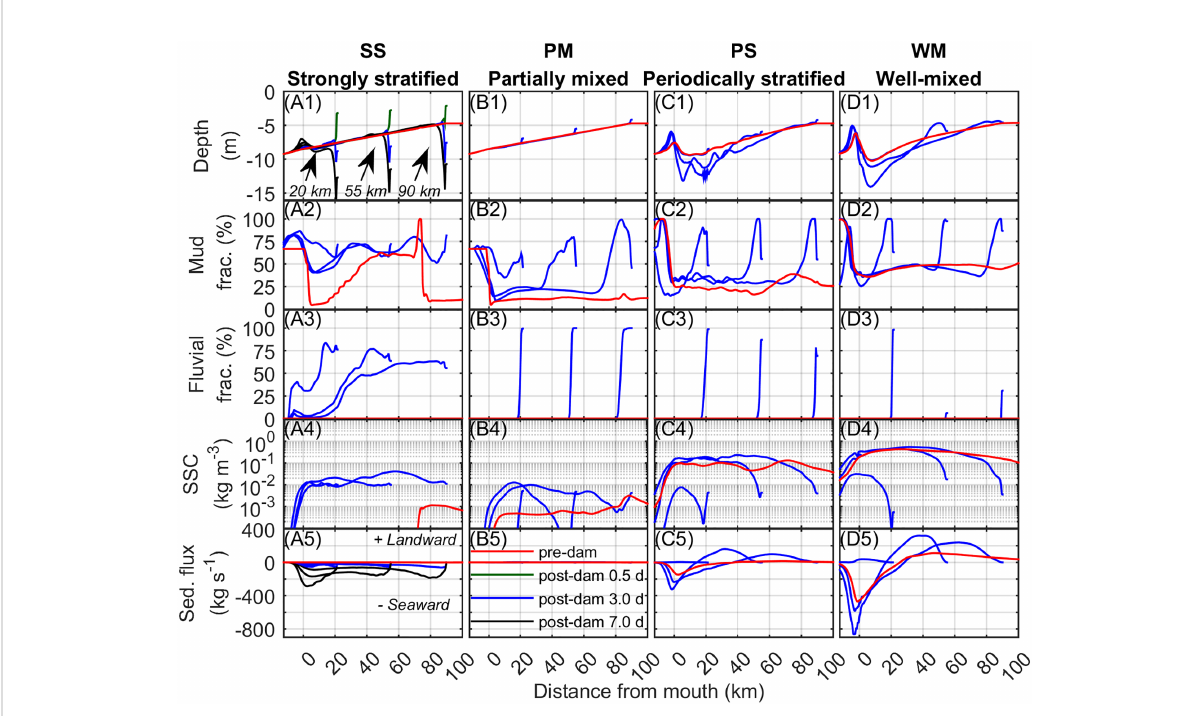
FIGURE 10 Pre-dam and post-dam along-channel pro fi les depending on estuarine dam location (dam at x = 20, 55, and 90 km) of (A1-D1) width-averaged channel depth (m), (A2-D2) width-averaged mud fraction (%) on bed surface, (A3-D3) width-averaged fl uvial sediment fraction (%) on bed surface, (A4-D4) depth-averaged suspended sediment concentration along channel thalweg (SSC, kg m -3 ), and (A5-D5) cross-sectionally integrated sediment fl ux (kg s -1 ). Most data correspond to D t = 3 day. In (A1, A5) D t = 0.5 and 7 day are also shown. Along-channel distance is distance from the estuarine mouth (positive landward). Negative current is